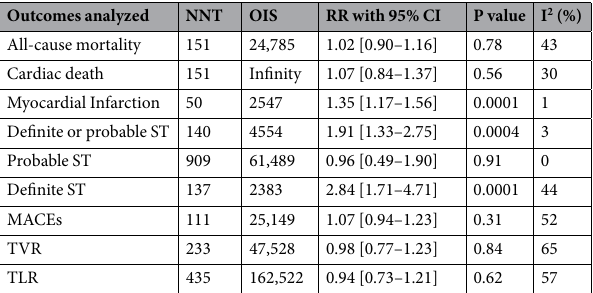
Table 5. Results of this analysis. Abbreviations: NNT: number needed to treat, OIS: optimal information size, ST: stent thrombosis, RR: risk ratios, CI: confidence intervals, MACEs: major adverse cardiac events, TVR: target vessel revascularization, TLR: target lesion